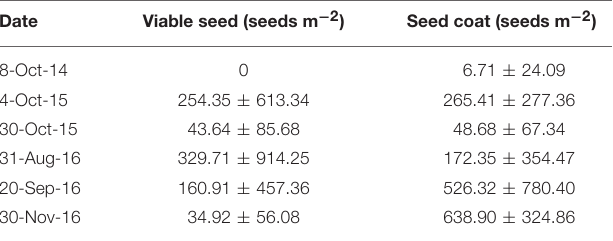
TABLE 3 | Densities of viable seeds and seed coats of Zostera marina L. in Huiquan Bay.